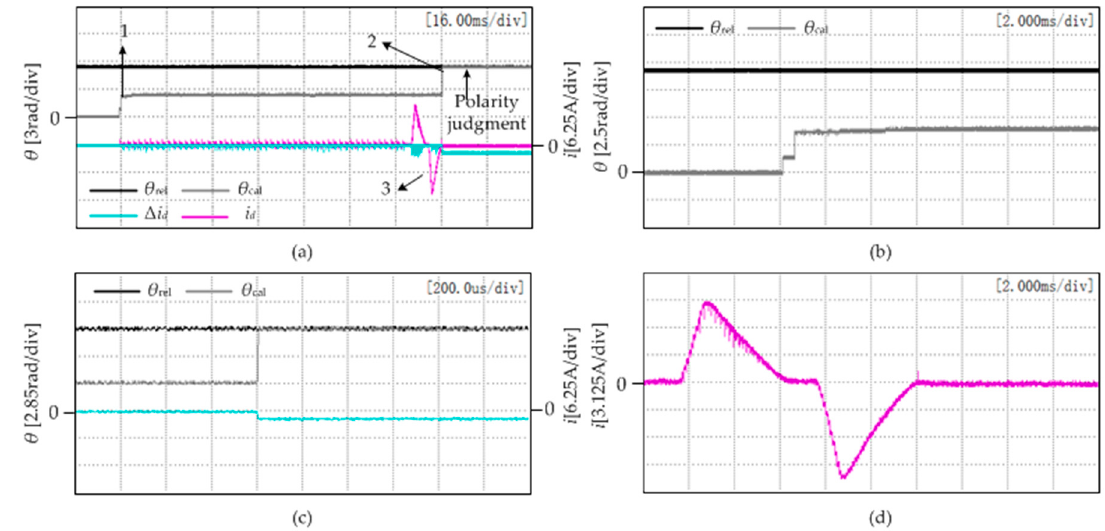
Figure 13. When θ = 307.33°: ( a ) angle comparison and d-axis current experimental waveforms; ( b ) amplified waveform of 1 area from Figure 12a; ( c ) amplified waveform of 2 area from Figure 12a; ( d ) amplified waveform of 3 area from Figure 12a.